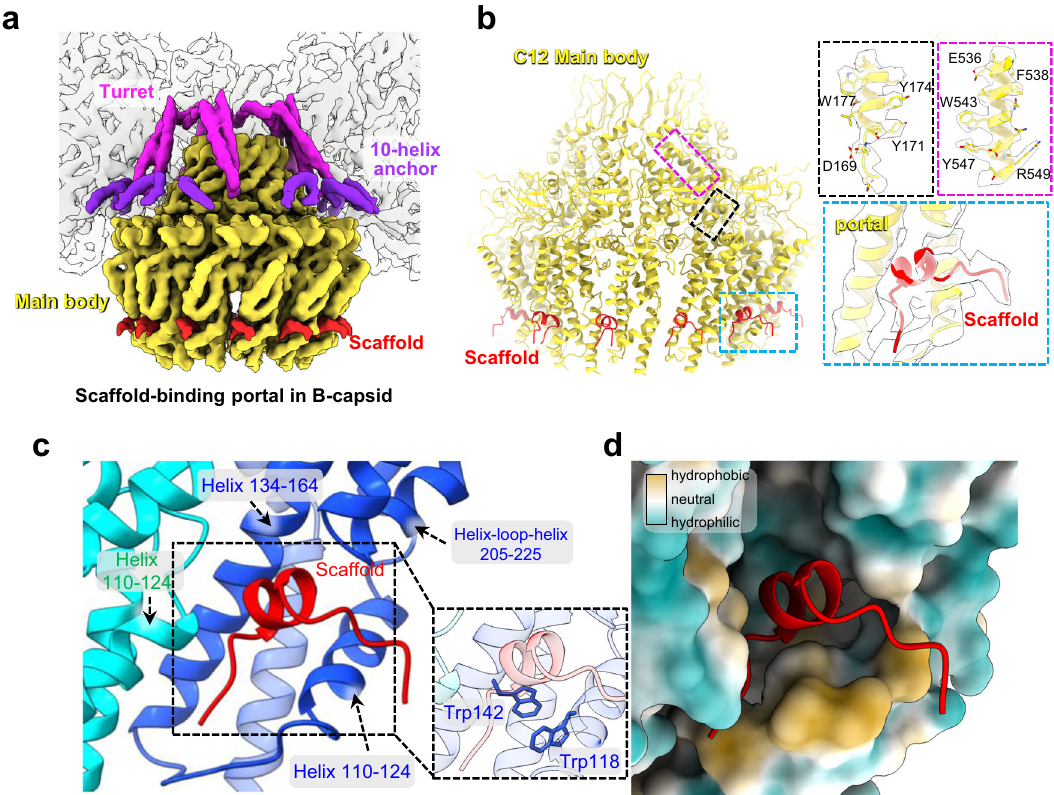
Fig.4|Structureoftheportal-scaffoldcomplexintheB-capsid.a Superposition of the C1 density map of the portal vertex region (transparent gray) with the composite cryoEMmap ofthe portaland theportal-bound scaffold intheB-capsid thatwasassembledfrom reconstructions asin Fig. 1. b Atomicmodel ofthe portal main body (yellow) and the portal-bound scaffold fragments (red). Insets are zoomed-in views of the boxed regions on the left, showing the CryoEM map and modelof residues 167 – 180(sharpened map, contour level: 2.5 σ ), residues535 – 550 (sharpened map, contour level: 3.0 σ ) of portal and the scaffold-binding region of